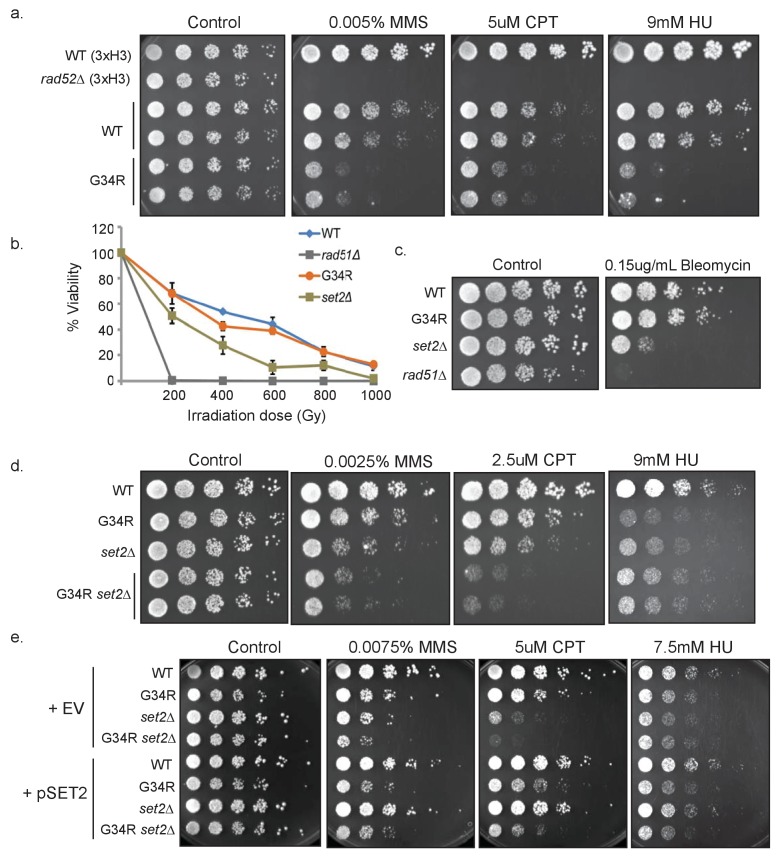
H3-G34R mutants show DNA damage sensitivity upon replication stress.(a) 5-fold serial dilutions showing the effect of methyl methanesulfonate (MMS), camptothecin (CPT), and hydroxyurea (HU) on the indicated strains. (b) Effect of γ−irradiation (IR) exposure on viability of H3-WT, H3-G34R, set2Δ, and rad51Δ cells. Data represent mean ± SEM from 2 biological replicate experiments. (c) Serial dilution assay showing the effect of bleomycin on the indicated strains. (d) Serial dilution assay showing the genotoxin sensitivity of H3-WT, H3-G34R, H3-WT set2Δ, and H3-G34R set2Δ cells upon MMS, CPT, or HU treatment. (e) Genotoxin sensitivity of indicated strains containing either an empty vector (EV) or a vector overexpressing Set2-3xFLAG (pSet2).